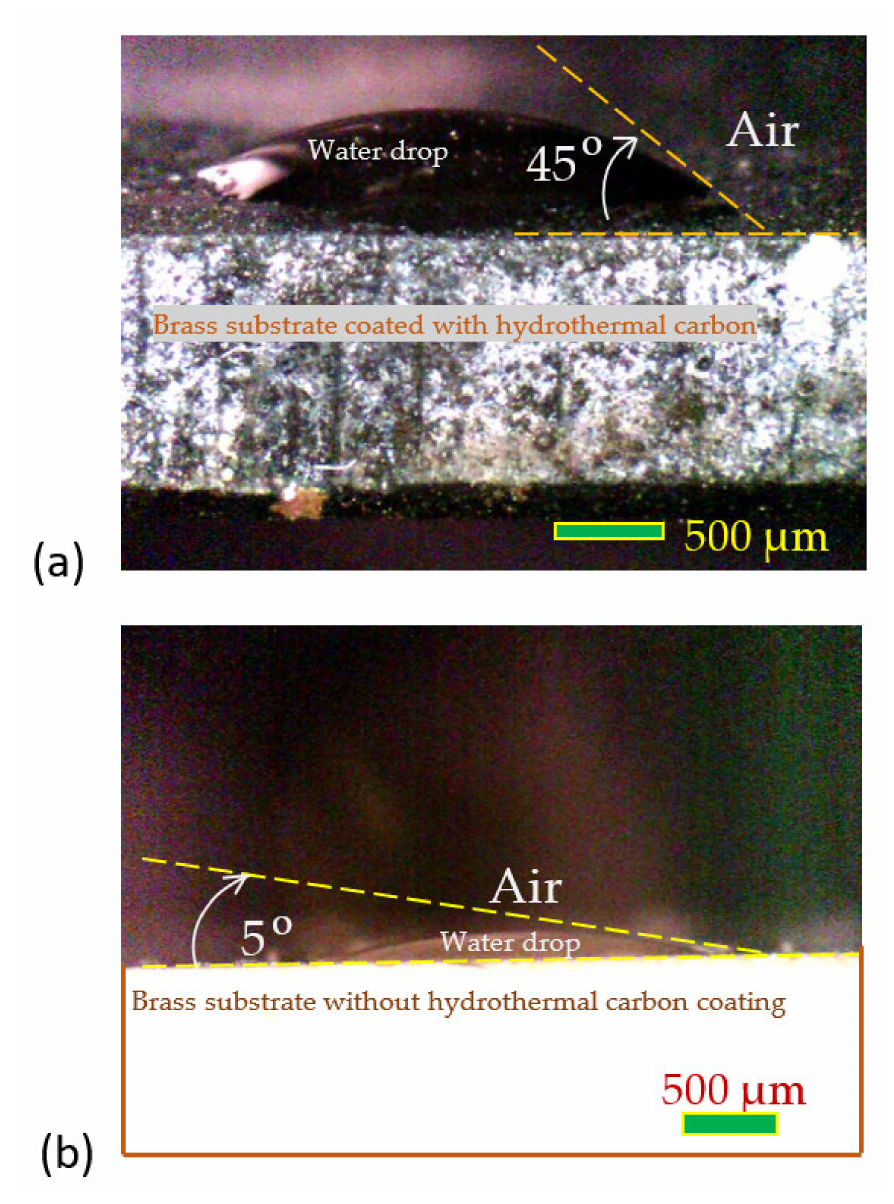
Figure 5. Optical images showing the wetting of seawater on ( a ) the hydrothermally carbonized coating, and ( b ) the brass specimen without the